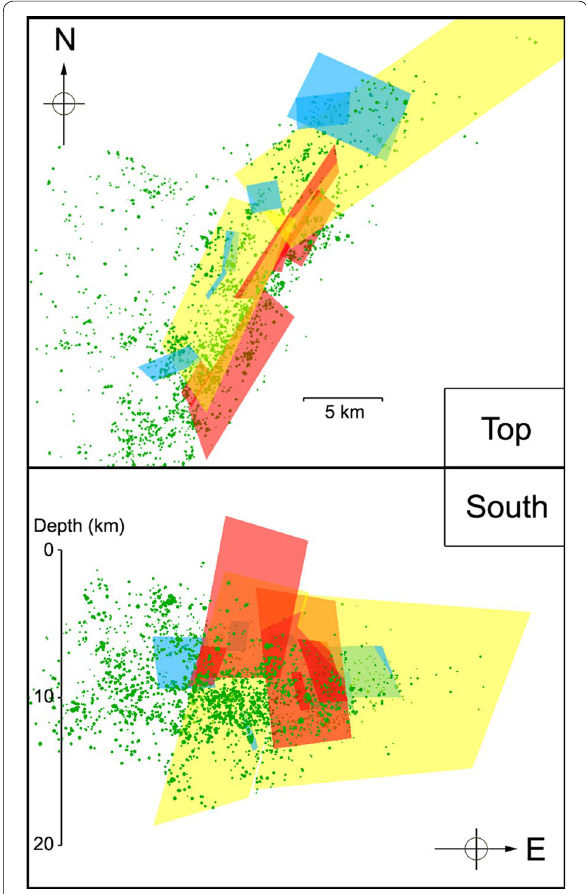
Fig. 10 Visualization of the assumed activated fault planes in top and south-side view; red squares foreshocks’ ruptures; blue = squares aftershocks’ ruptures; yellow rectangles mainshock’s = = rupture adopted from Asano and Iwata (2016); green dots relative = locations of earthquakes inferred by Kato et al. (2016) for period April 14–May 13, 2016. The scale in figure is only orientative, because of used perspective